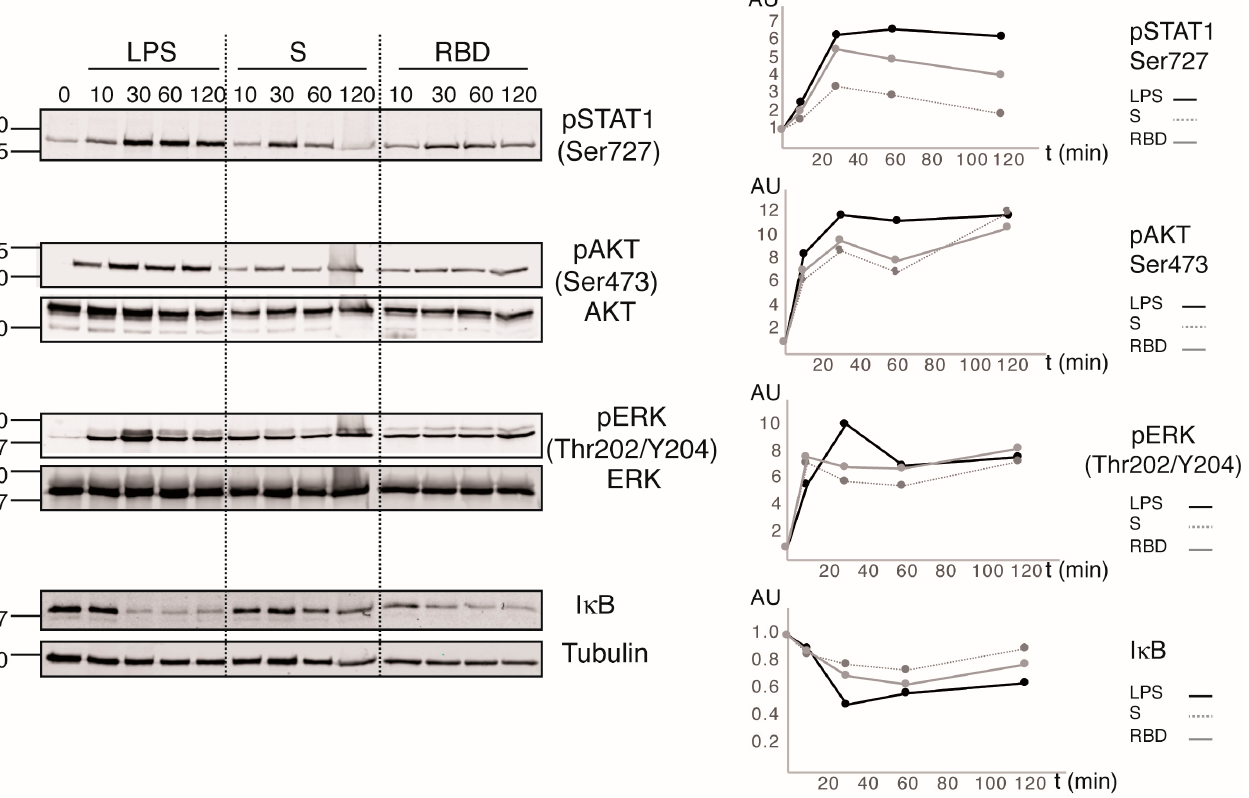
Figure 5. Spike protein and RBD of SARS-CoV-2 triggers AKT, ERK, and STAT1 activation on DCs. Cells were treated with different stimuli for the times indicated. Cells lysates were analyzed by immunoblot using the indicated antibodies. Densitometric analysis was performed using Image J software (v 2.1.0/1.53c). Phosphorylation status of AKT and ERK was normalized to that of the total non-phosphorylated protein, whereas STAT1 phosphorylation and I κ B degradation were determined using Tubulin as loading control. Relative values were determined by considering the basal condition = 1 and illustrated in the corresponding graphics in the right. Data shows the results of one donor; additional independent experiments made with the other three donors showed a similar